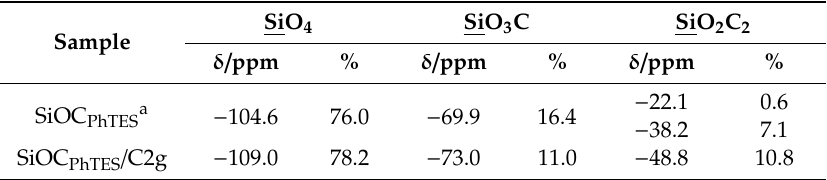
Figure 2. 29 Si MAS-NMR spectra of the SiOC PhTES and SiOC PhTES /C2g samples. Data obtained from fitting of 29 Si MAS-NMR spectra of the pure ceramic and the composite